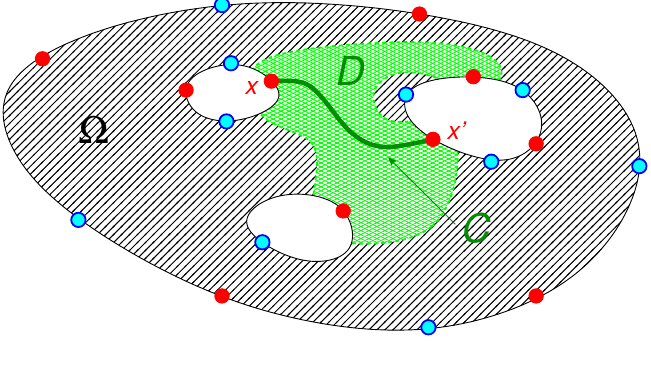
Figure 6: A domain Ω ⊂ R 2 of high genus with sign changes along boundary